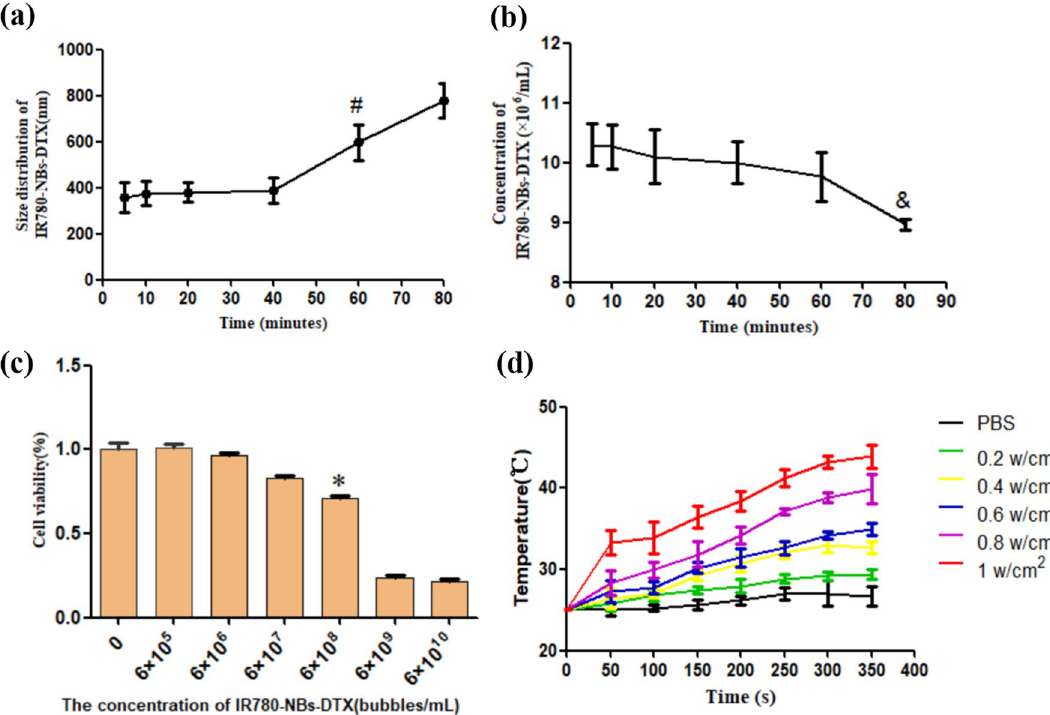
Figure 5. The stability, biocompatibility and photothermal effect of IR780-NBs-DTX. ( a , b ) Changes in the size distribution and concentration of IR780-NBs-DTX over 80 min. # P < 0.05, significantly different from the size distribution at 5 min; & P < 0.05, significantly different from the concentration at 5 min. ( c ) The cytotoxicity of IR780-NBs-DTX at different concentrations (0: control cells; 6 × 10 5 /mL; 6 × 10 6 /mL; 6 × 10 7 /mL; 6 × 10 8 / mL; 6 × 10 9 /mL; 6 × 10 10 /mL). *P < 0.05, significantly different from the cytotoxicity in control cells. ( d ) The photothermal effect of IR780-NBs-DTX under an 808 nm laser at different